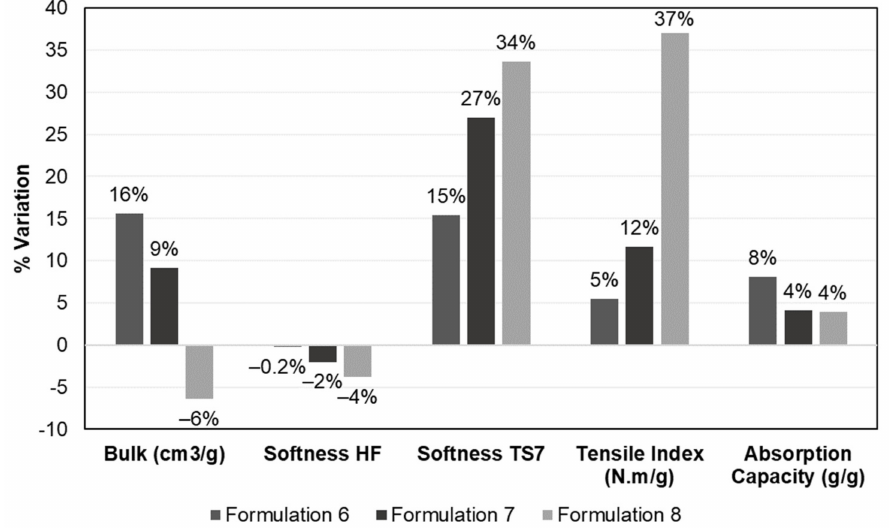
Figure 8. Percentage of variation in the properties of bulk, softness HF, softness TS7, tensile index and water absorption capacity of formulations 6, 7 and 8 compared with formulation 1 obtained with